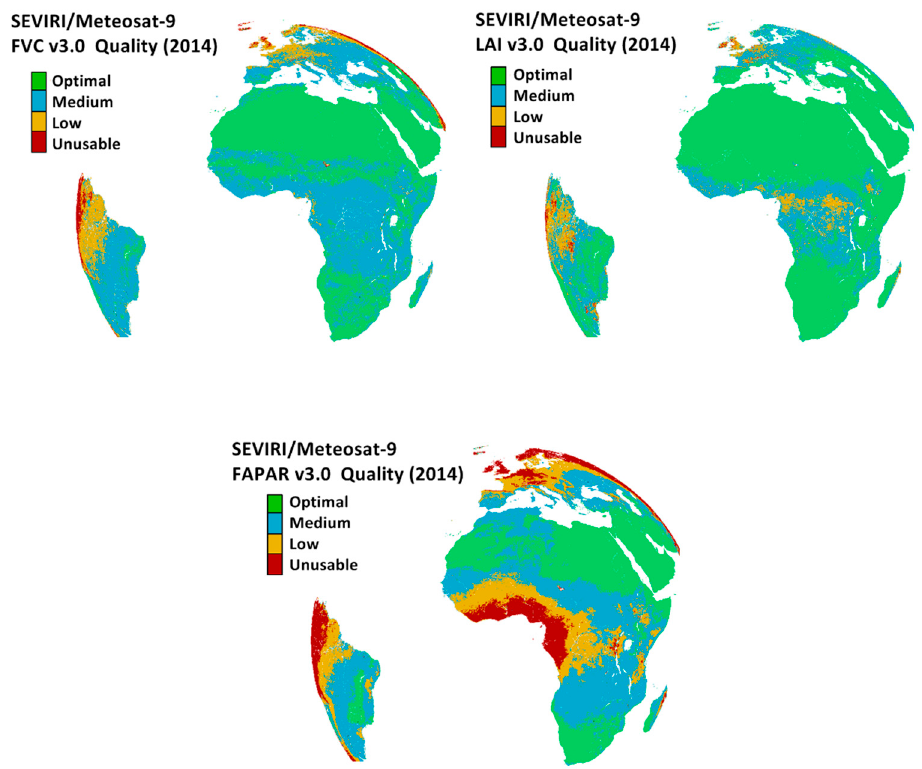
Figure 7. Quality of the MSG daily FVC, LAI and FAPAR products based on the information provided by the mean values of its theoretical uncertainty along the year 2014. The levels of accuracy stand for: Optimal (Err(FVC / FAPAR) < 0.05; Err(LAI) < 0.5); Medium (0.05 < Err(FVC / FAPAR) < 0.10; 0.5 < Err(LAI) < 1.0); Low (0.10 < Err(FVC / FAPAR) < 0.12; 1.0 < Err(LAI) < 1.5); Poor (Err(FVC / FAPAR) > 0.15; Err(LAI) > 1.5).